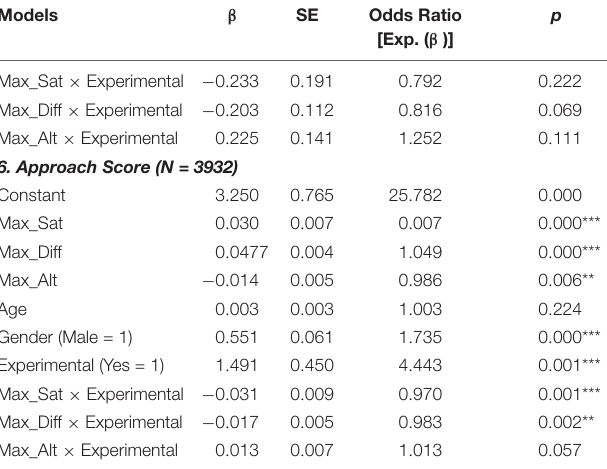
TABLE 3 | Multi-level model outcomes for all variables ( N =